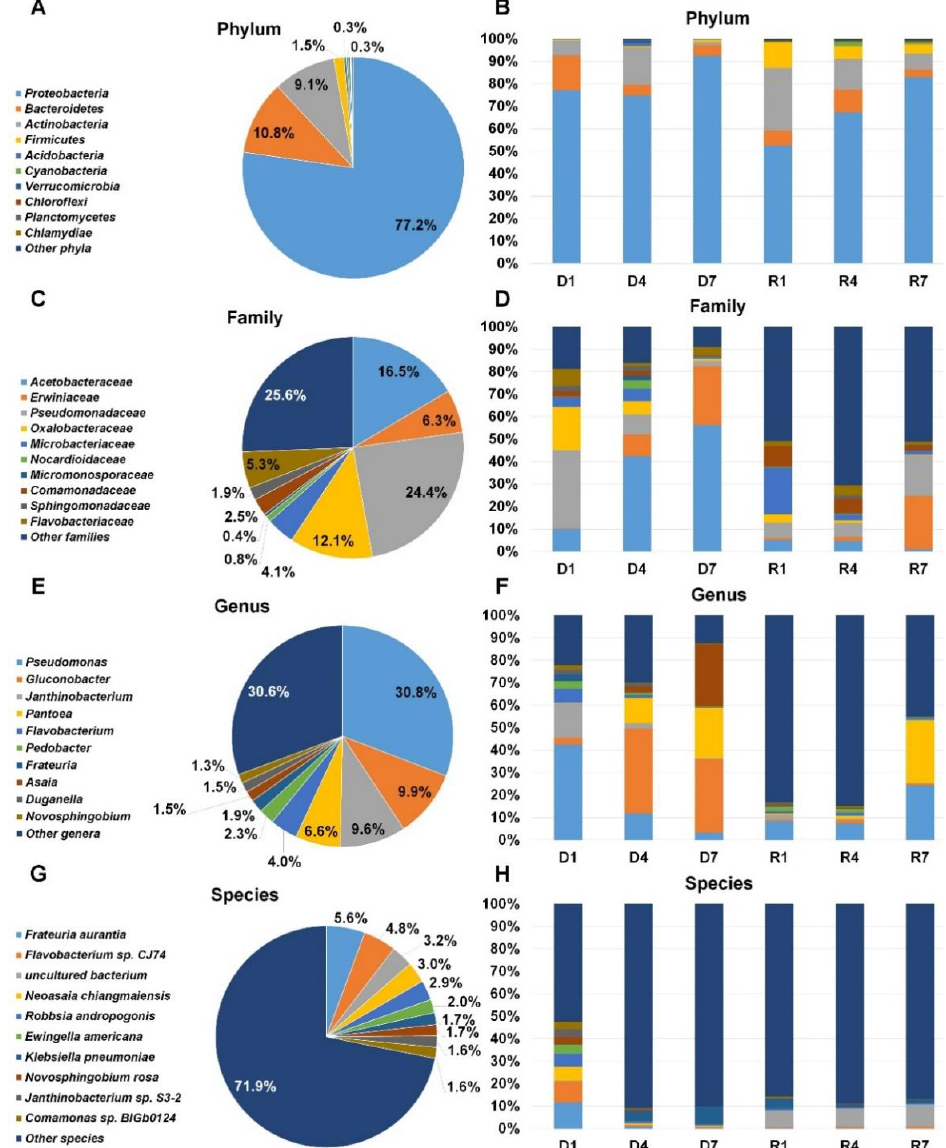
Figure 7. Taxonomy classification of identified bacteria from six different libraries. Results of BLASTX using DIAMOND were subjected to MEGAN6 to classify taxonomy of identified organisms according to phylum ( A ), family ( C ), genus ( E ), and species ( G ). For simplicity, only proportion of representative bacteria taxonomy was visualized. The proportion of identified major bacterial taxonomy according to phylum ( B ), family ( D ), genus ( F ), and species ( H ).